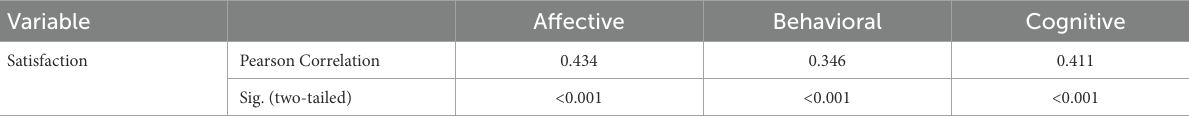
TABLE 5 Coefficient